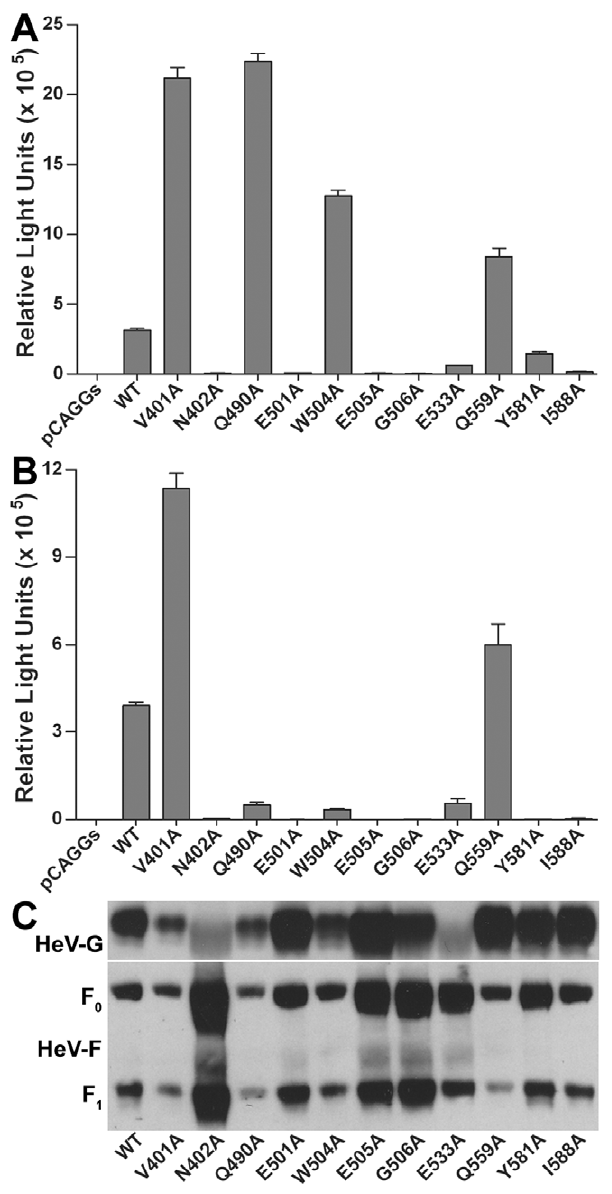
Figure 7. Expression and receptor binding activity of structure- based HeV-G mutations. The various alanine substitution mutants or wild-type (WT) HeV-G were transiently expressed in the absence (A) or presence (B) of HeV-F in HeLa-USU cells. Cell lysates were prepared and equal amounts were co-precipitated with recombinant ephrin-B2/Fc or ephrin-B3/Fc, or directly immunoprecipitated with polyclonal G-specific antibodies (control), followed by protein G Sepharose beads. The precipitated samples were processed and analyzed by 4 to 20% gradient SDS-PAGE and Western blotting with HeV- G-specific antiserum. This experiment was repeated three times and one representative experiment is shown.